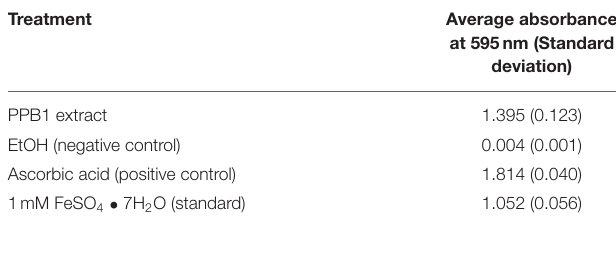
TABLE 4 | Average cell viability of S. aureus in various treatments ( n = 3).